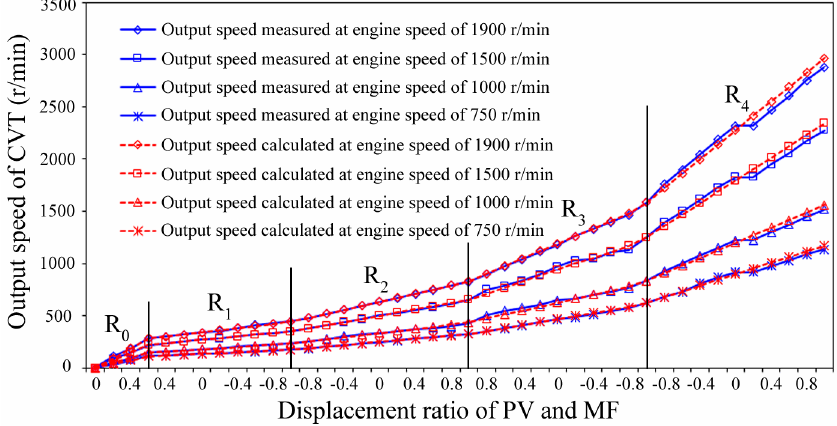
Figure 3. Output speed of the CVT at different engine speeds and displacement ratios. PV, variable displacement pump; MF, fixed displacement motor.